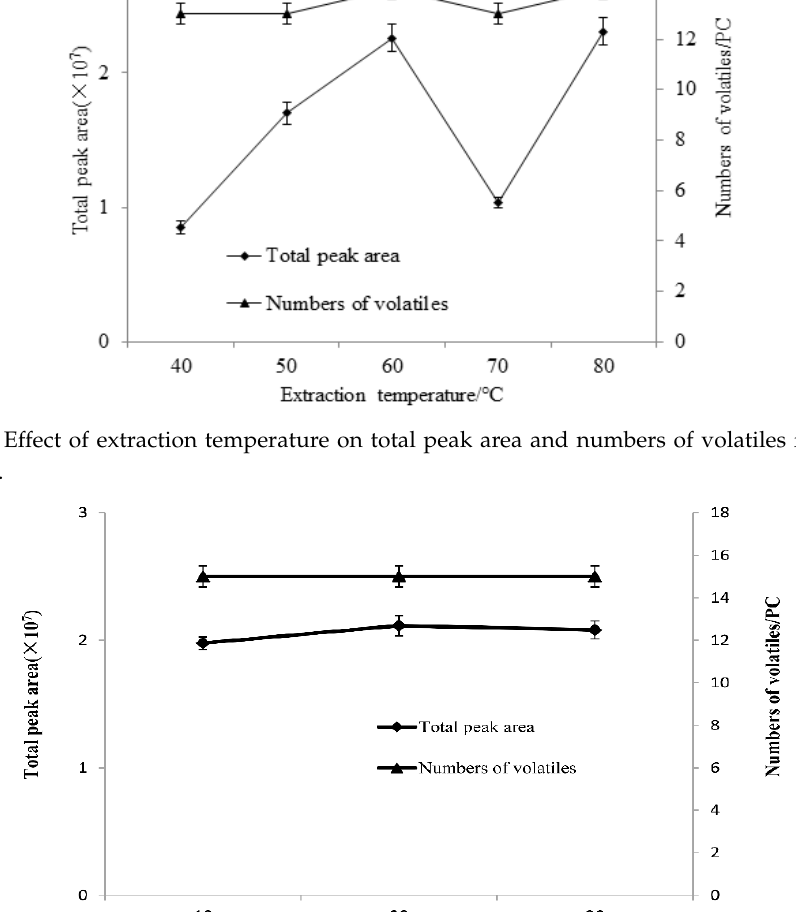
Figure 3. Effect of extraction temperature on total peak area and numbers of volatiles from stink tofu brine.